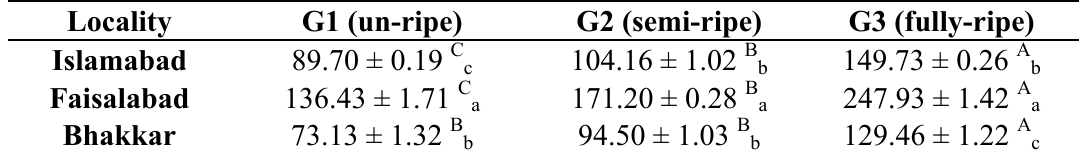
104.16 ± 1.02 B 149.73 ± 0.26 A b b c 171.20 ± 0.28 B 247.93 ± 1.42 A a a a 94.50 ± 1.03 B 129.46 ± 1.22 A b b c